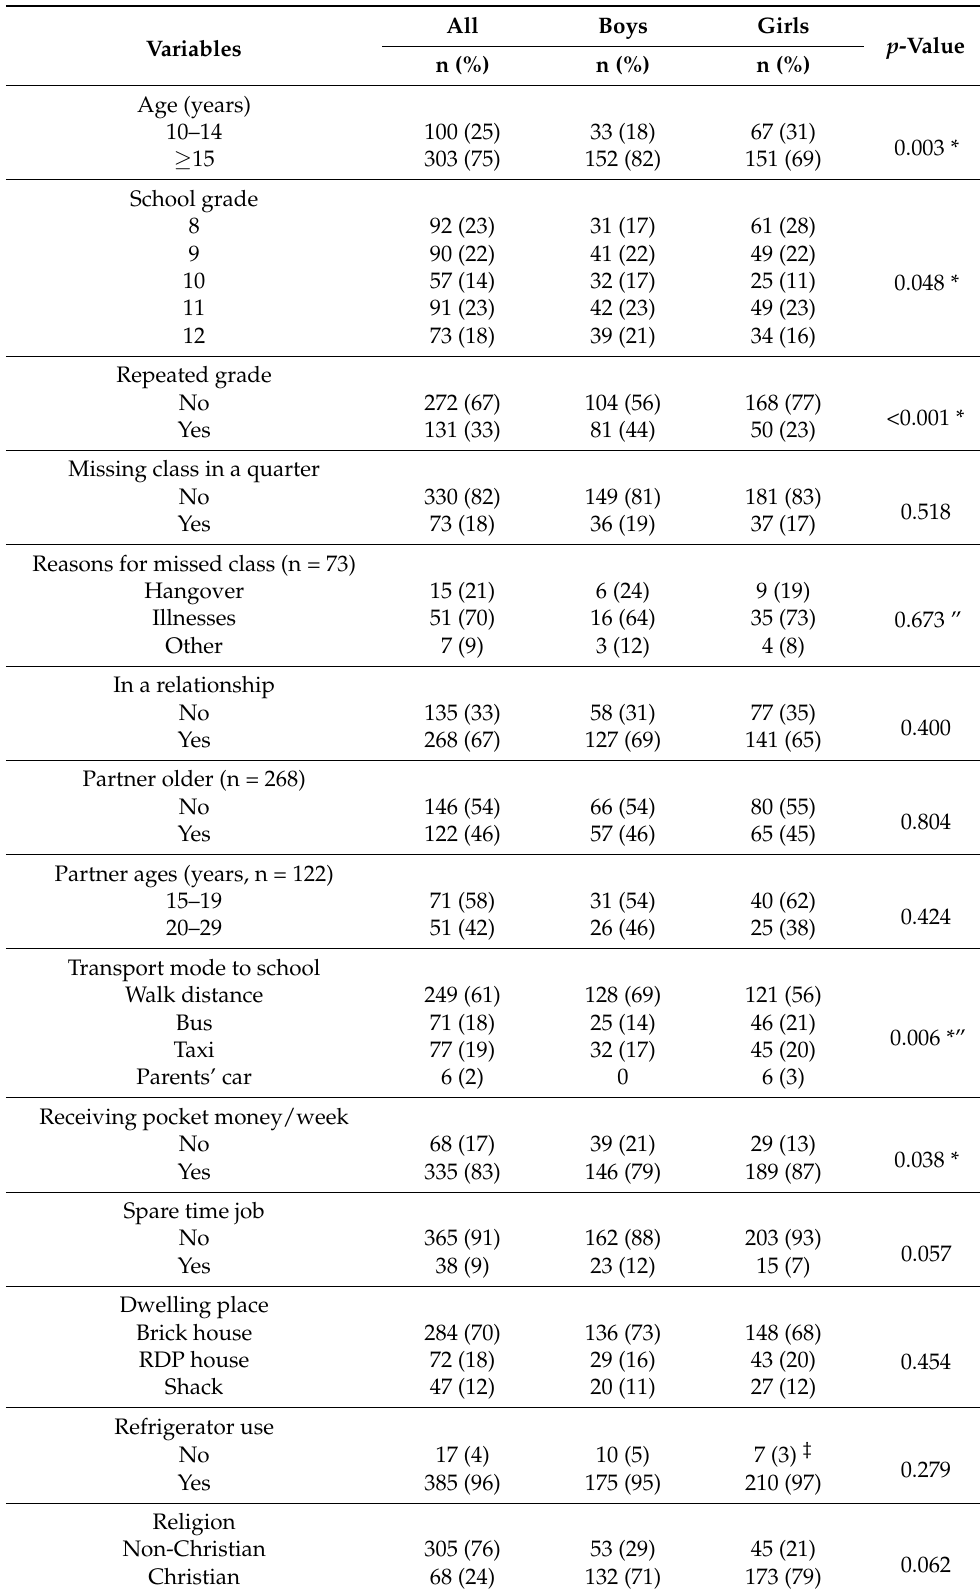
Table 1. Demographic characteristics of school